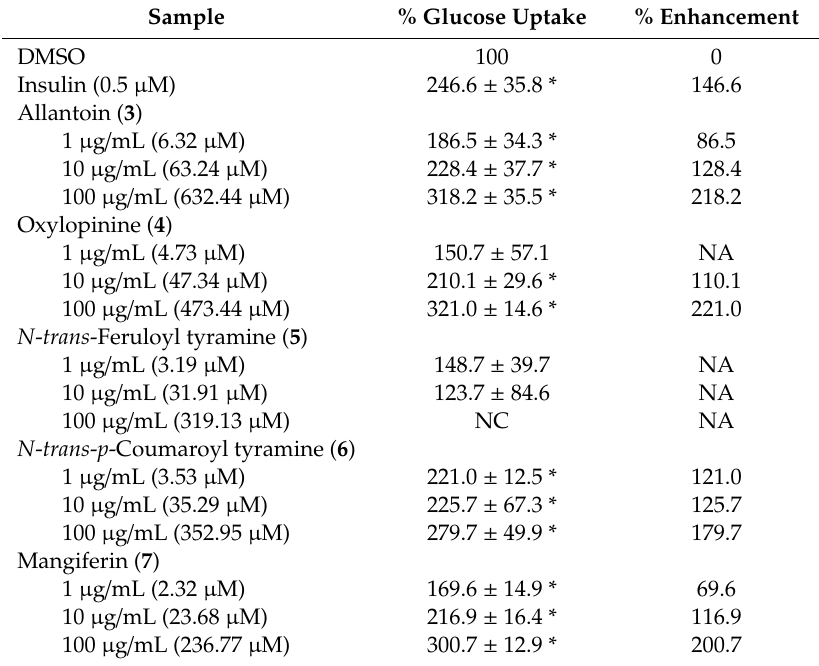
Table 3. Glucose uptake stimulatory activity of compounds 3 –